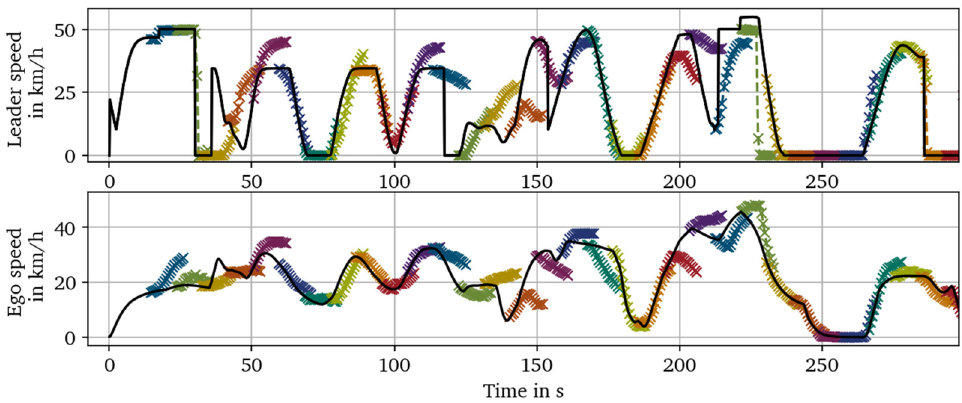
Figure 12. Comparison of predicted (colored) and actual (black) ego and leader speeds on Route 5.